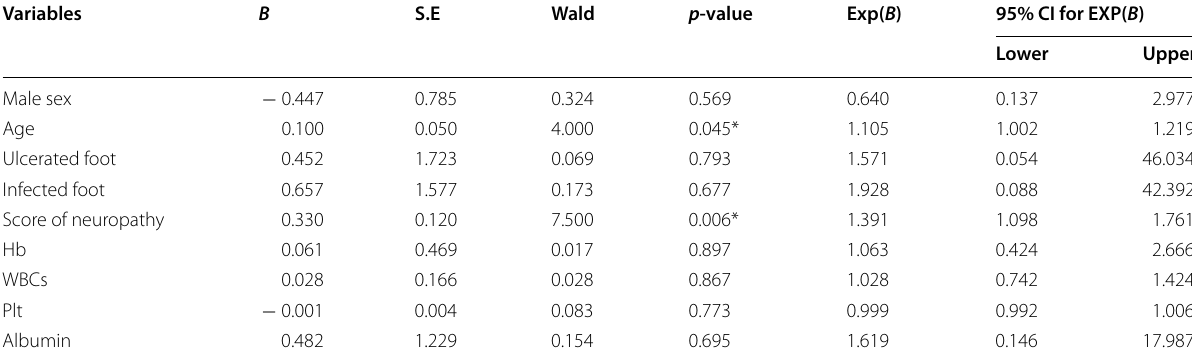
R 2 0.38 Chi-square test for model coefficient = hemoglobin, WBCs, platelets, albumin